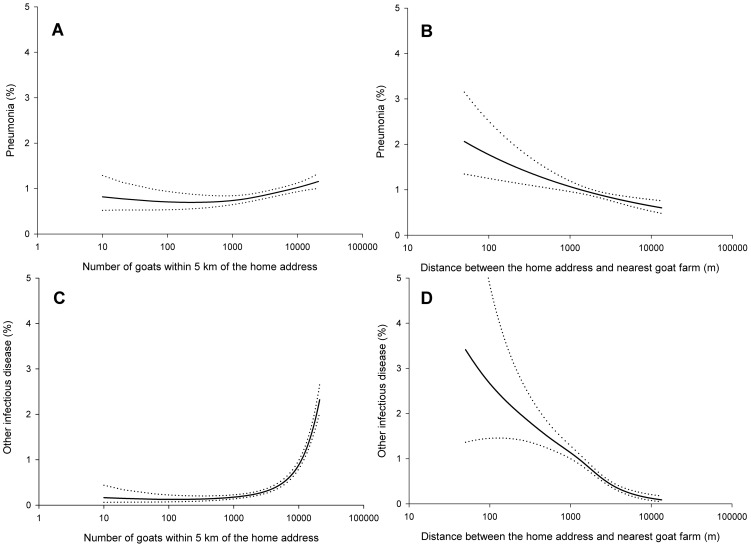
Smoothed plots with 95% confidence bands representing associations of the number of goats within 5 km around the home address with pneumonia (A; P = 0.001) and ‘other infectious disease’ (C; P<0.0001), and associations of distance to nearest goat farm with pneumonia (B; P = 0.0002) and ‘other infectious disease’ (D; P<0.0001) among 70,142 adults.Associations were adjusted for age and sex.